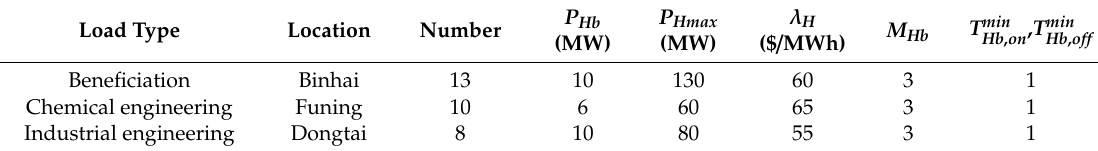
Table 2. Parameters of Shiftable load